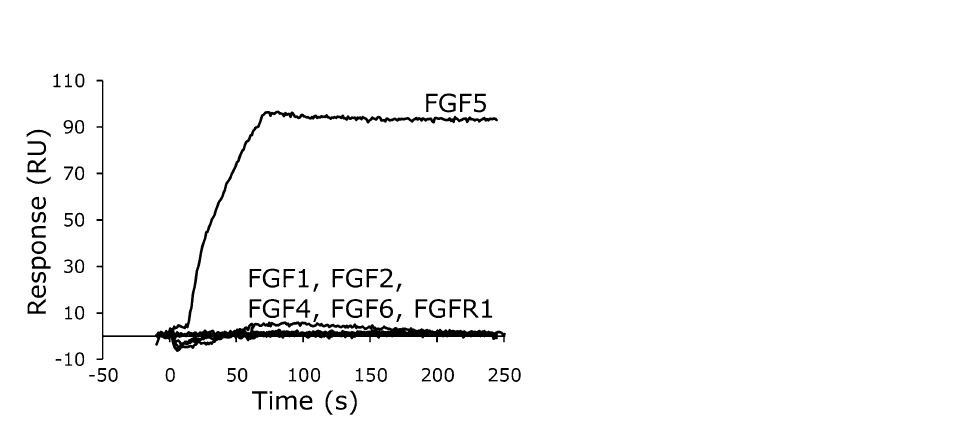
Table 2. Kinetic parameters of aptamer binding to FGF5 a . a The kinetic parameters are represented by the mean ± standard error from three independent measurements.